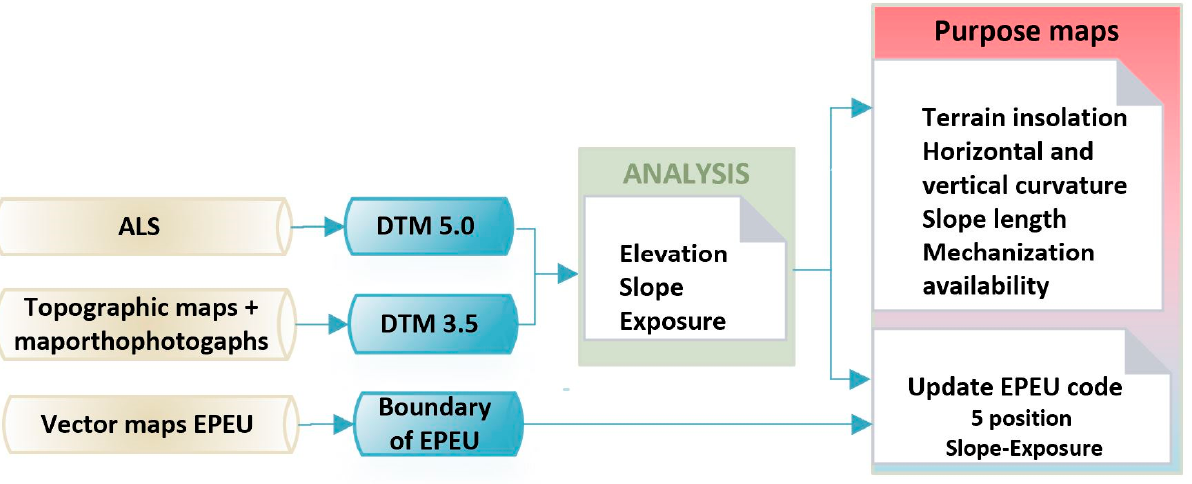
Figure 5. Flowchart of the methodology used.